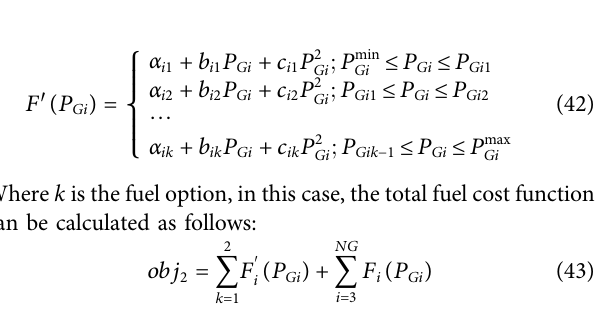
FIGURE 2 | Convergence characteristics of the algorithms for Case 1.